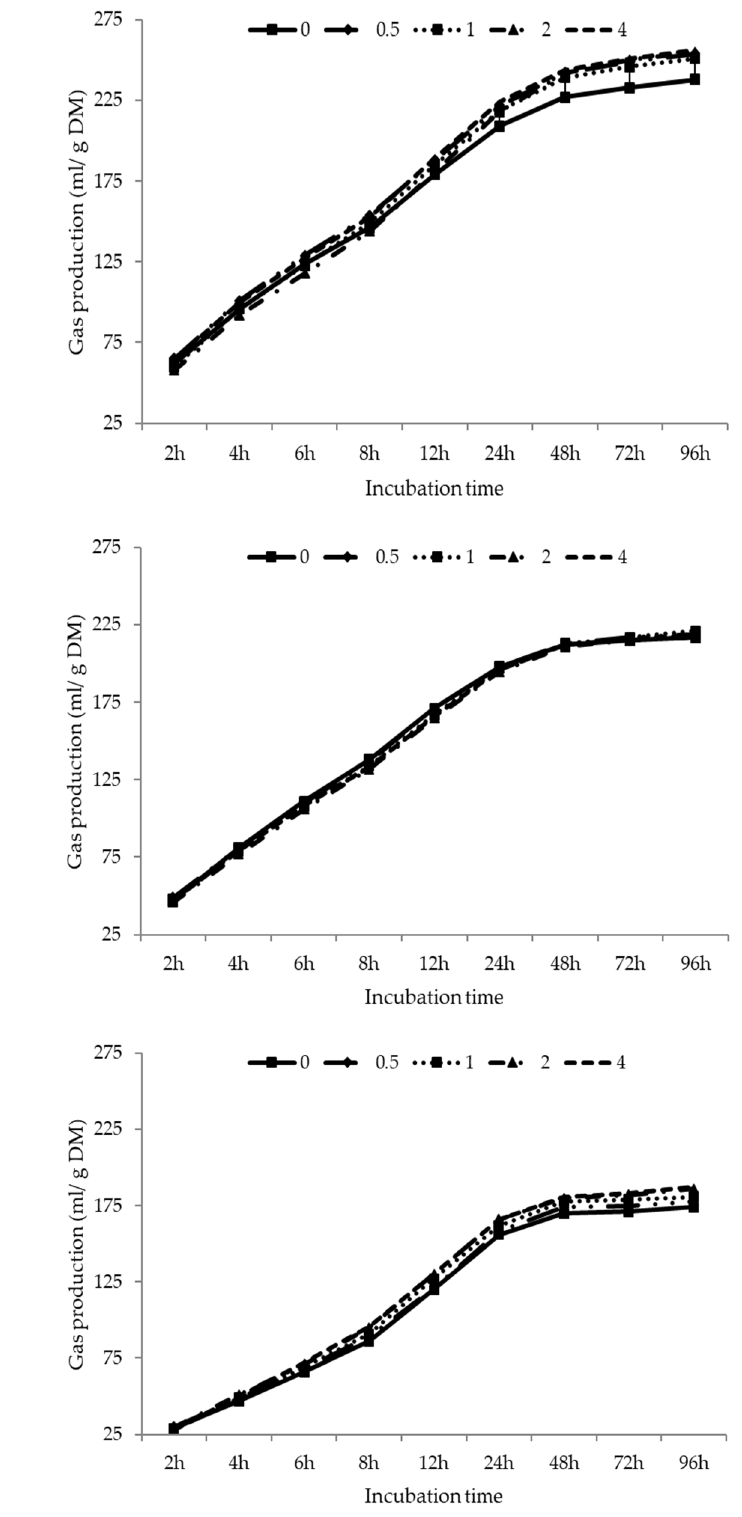
Figure 1. Effects of FFA supplemented to pretreated SFH (( A ): SFH out , ( B ): SFH NaOH , ( C ): SFH urea ) on the volume of in vitro gas production.